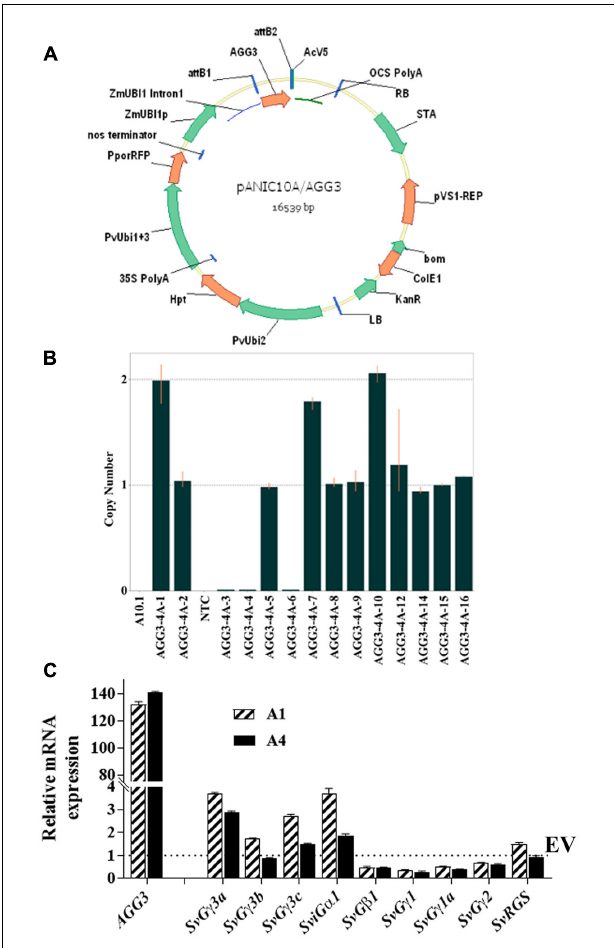
FIGURE 1 | Generation of Setaria AGG3 overexpression lines. (A) Map of the expression vector used for cloning a monocot codon optimized Arabidopsis AGG3 gene. (B) Identification of the homozygous families from single insert AGG3-4A transgenic plants in T1 generation using Taqman assay (C) Expression analysis of AGG3 transgene and endogenous Setaria G-protein genes by qRT-PCR analysis. Transcript levels of indicated genes were determined in EV and AGG3-OE (A1 and A4) lines using cDNA isolated from 10-day-old S. viridis seedlings. The expression values of EV, A1 and A4 were normalized with Setaria ubiquitin gene. Dotted line represents the expression level of SvG γ 3a, SvG γ 3b, SvG γ 3c, SviG α 1, SvG β 1, SvG γ 1, SvG γ 1a, SvG γ 2, SvRGS in the EV (assigned as 1). The values are presented as the mean ± SE of three biological replicates and represented as fold changes. EV, Setaria plants overexpressing the empty vector; A1, A4 are the two independent transgenic lines for AGG3 overexpression (